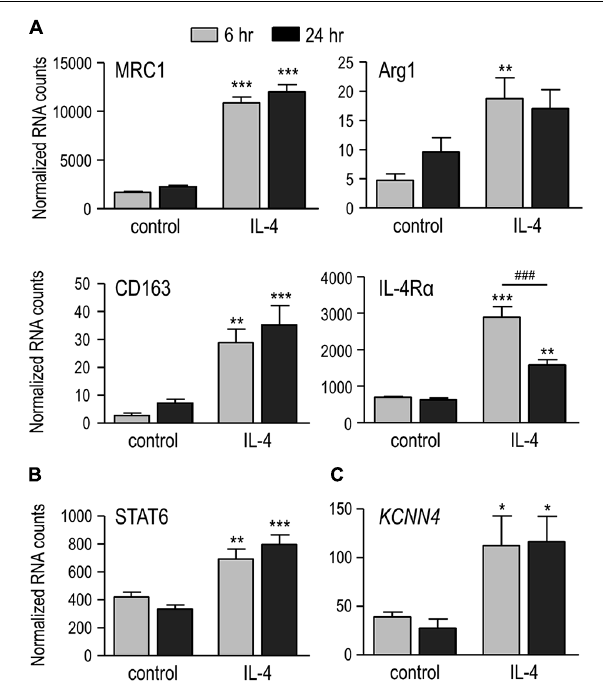
FIGURE 1 | IL-4 treatment induces alternative activation, and up-regulates IL-4 signaling genes and KCNN4 mRNA. (A) Treating rat microglia with rat recombinant IL-4 (20 ng/ml; 6 or 24 h) up-regulated expression of “alternative” activation markers: C-type mannose receptor 1 (MRC1), IL-4 receptor α subunit (IL-4R α ), CD163 and arginase 1 (Arg1). (B,C) Also up-regulated were “signal transducer and activator of transcription 6” (STAT6), a transcription factor involved in the IL-4 signaling pathway; and the Ca 2 + -activated K + channel, KCNN4 . Gene expression was analyzed using NanoString and normalized to the housekeeping gene, HPRT1 .Values are expressed as mean ± SEM for five replicates from different cell cultures.Two-way ANOVA with Bonferroni’s post hoc test revealed differences between unstimulated and IL-4-treated microglia ( ∗ ) and some time-dependent changes (#). One symbol indicates p < 0.05, two symbols, p < 0.01, three symbols, p < 0.001.